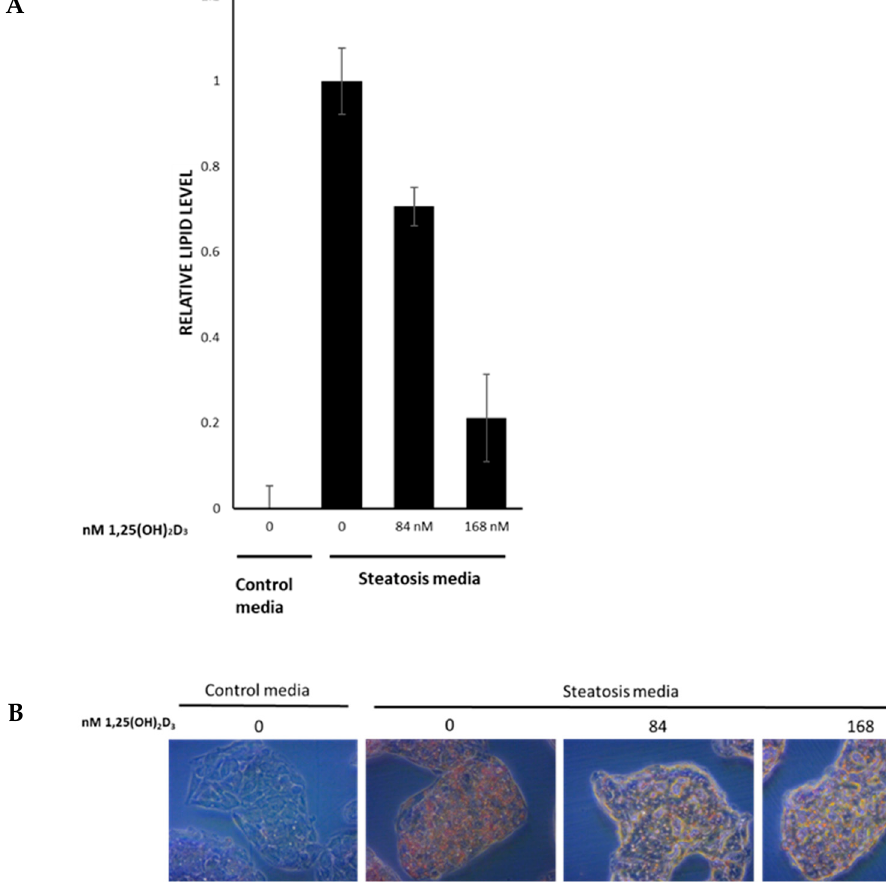
Figure 4. The effect of 1,25(OH) 2 D 3 on lipid accumulation in HepG2 cells. ( A ) Oil Red O staining of HepG2 cells treated with steatosis medium with different concentrations of 1,25(OH) 2 D 3 . ( B ) Relative measurement of Oil Red O levels extracted from HepG2 cells treated with steatosis medium with different concentrations of 1,25(OH) 2 D 3 . Error bars represent standard error of the mean. n = 3 for VitD treatments and n = 4 for controls.